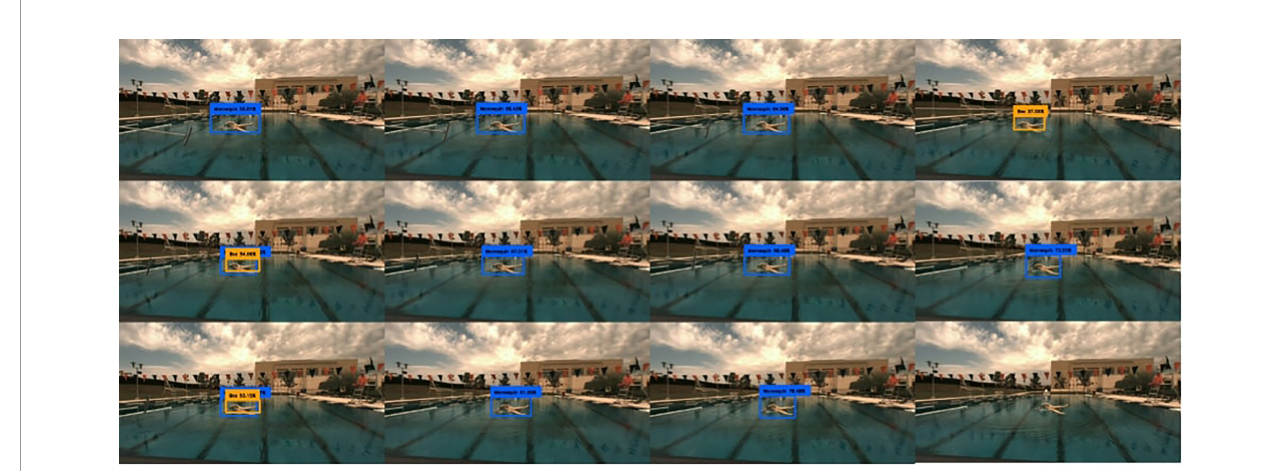
FIGURE 8 | Continuous detection and tracking performance of the proposed model.